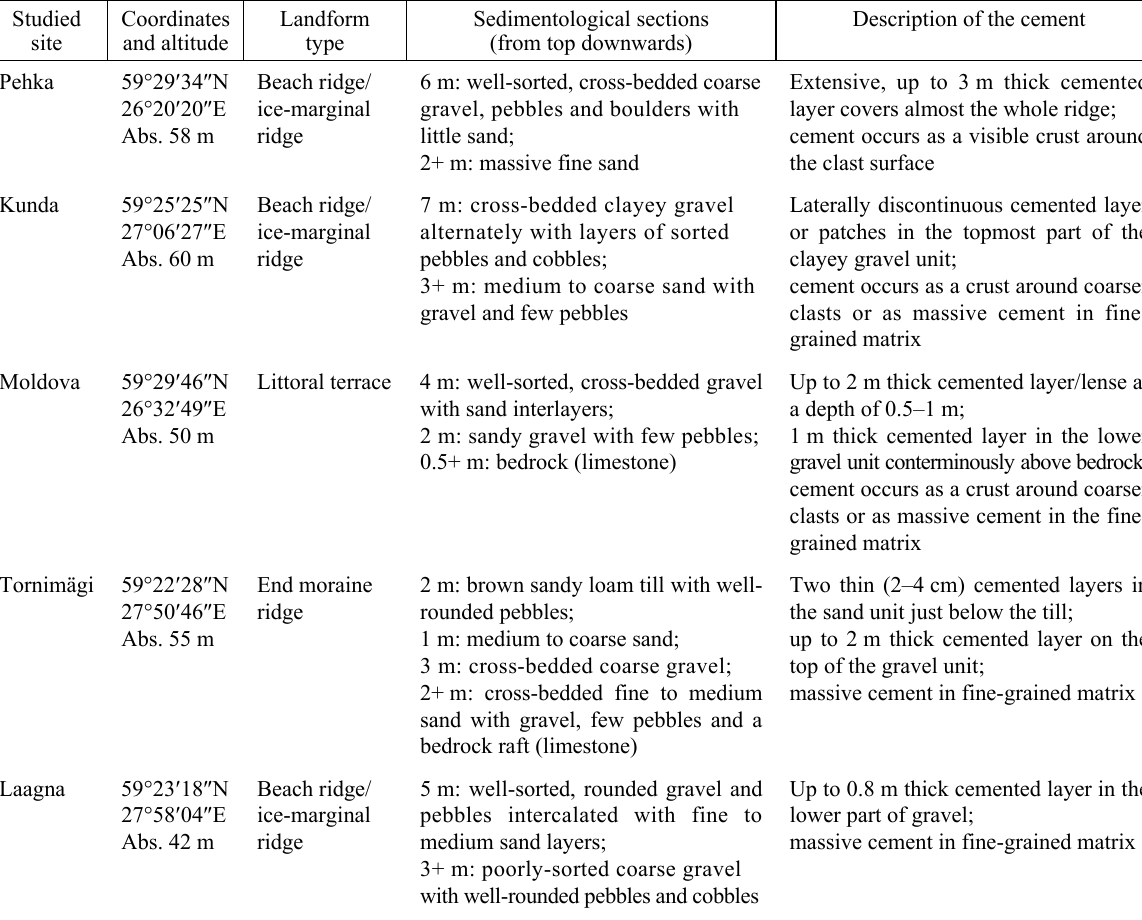
Description of the cement